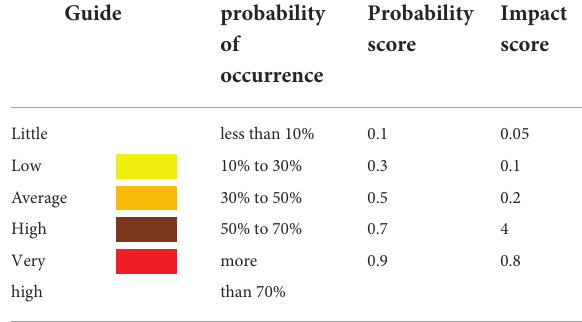
TABLE 2 The exposure ranking calculated based on the exposure rate (34). ER = E OEL